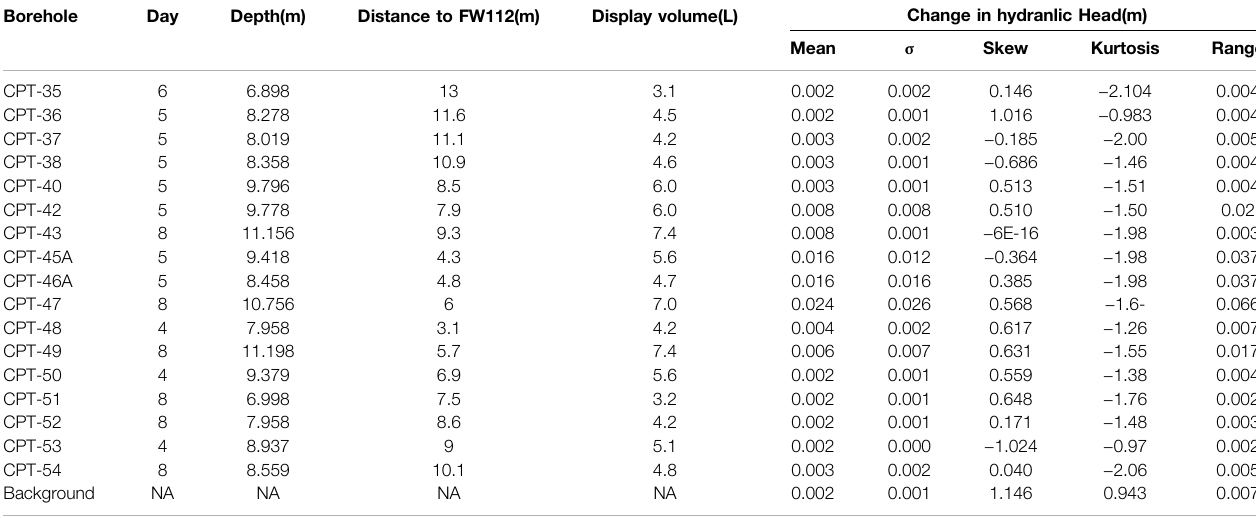
TABLE 1 | CPT push details and effect on hydraulic head measurements in